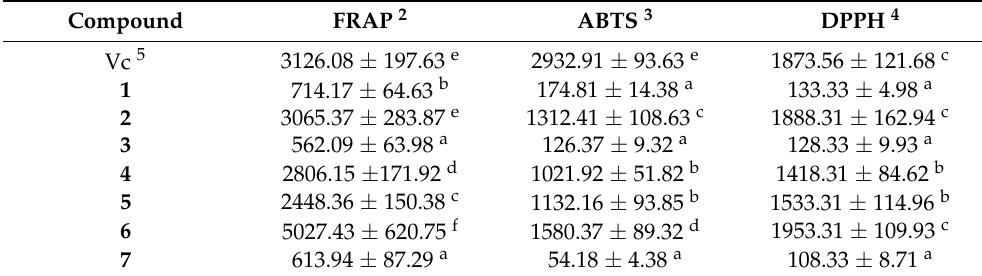
Table 2. Antioxidant capacity values of seven compounds from Anneslea fragrans Wall 1 . Compound FRAP 2 ABTS